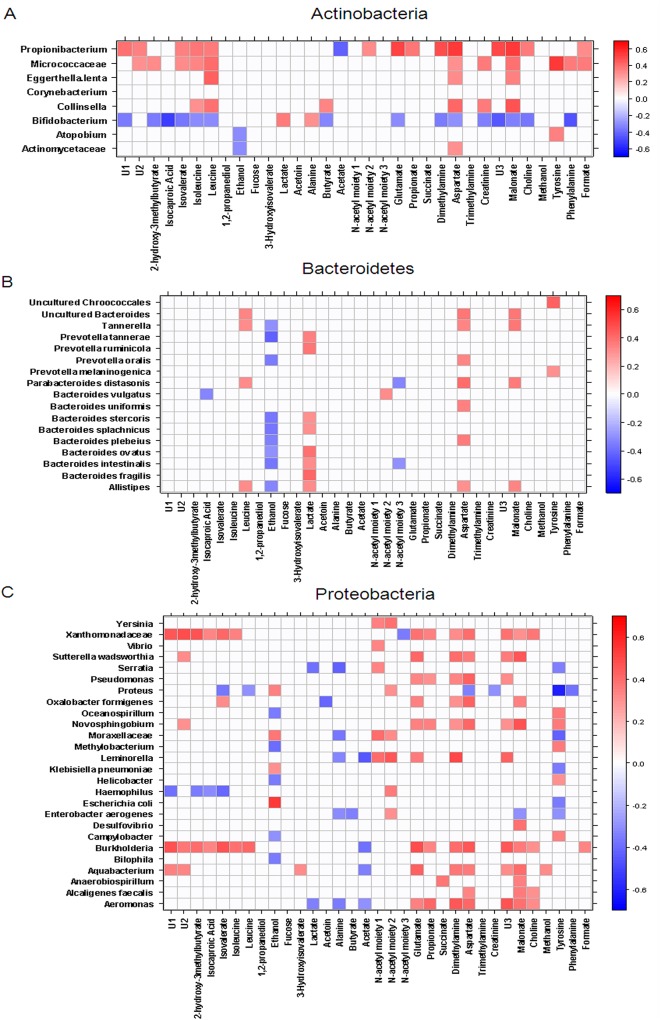
Correlation heat-map between OTUs and faecal metabolites.Significant correlations (p<0.05) for Actinobacteria (Panel A), Bacteroidetes (Panel B), Proteobacteria (Panel C). 2OH3MB: 2-hydroxy-3-methylbutyrate; Isocapr: Isocaproate; Isoval: Isovalerate; Ile: Isoleucine; Leu: Leucine; EtOH: Ethanol; Fuc: Fucose; 3OH-Isoval: 3-hydroxyisovalerate; Lac: Lactate; Ala: Alanine; But: Butyrate; Ac: Acetate; N-Ac: N-Acetyl moiety; Glu: Glutamate; Suc: Succinate; DMA: Dimethylamine; Asp: Aspartate; TMA: Trimethylamine; Cr: Creatine; MA: Malonate; Cho: choline; MeOH: Methanol; Tyr: Tyrosine; Phe: Phenylalanine; For: Formate.